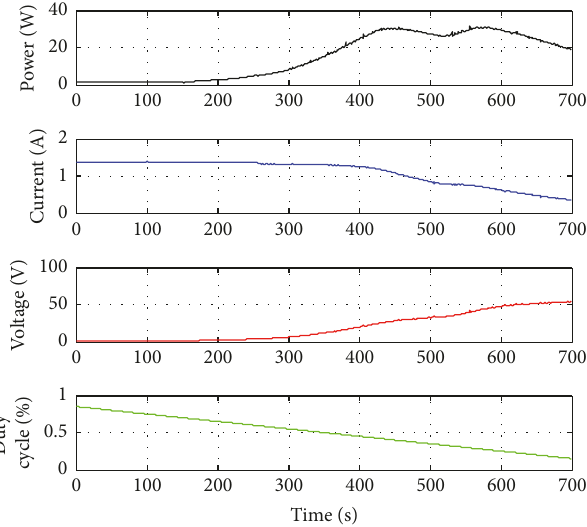
Figure 8: Experimental platform of PV MPPT.